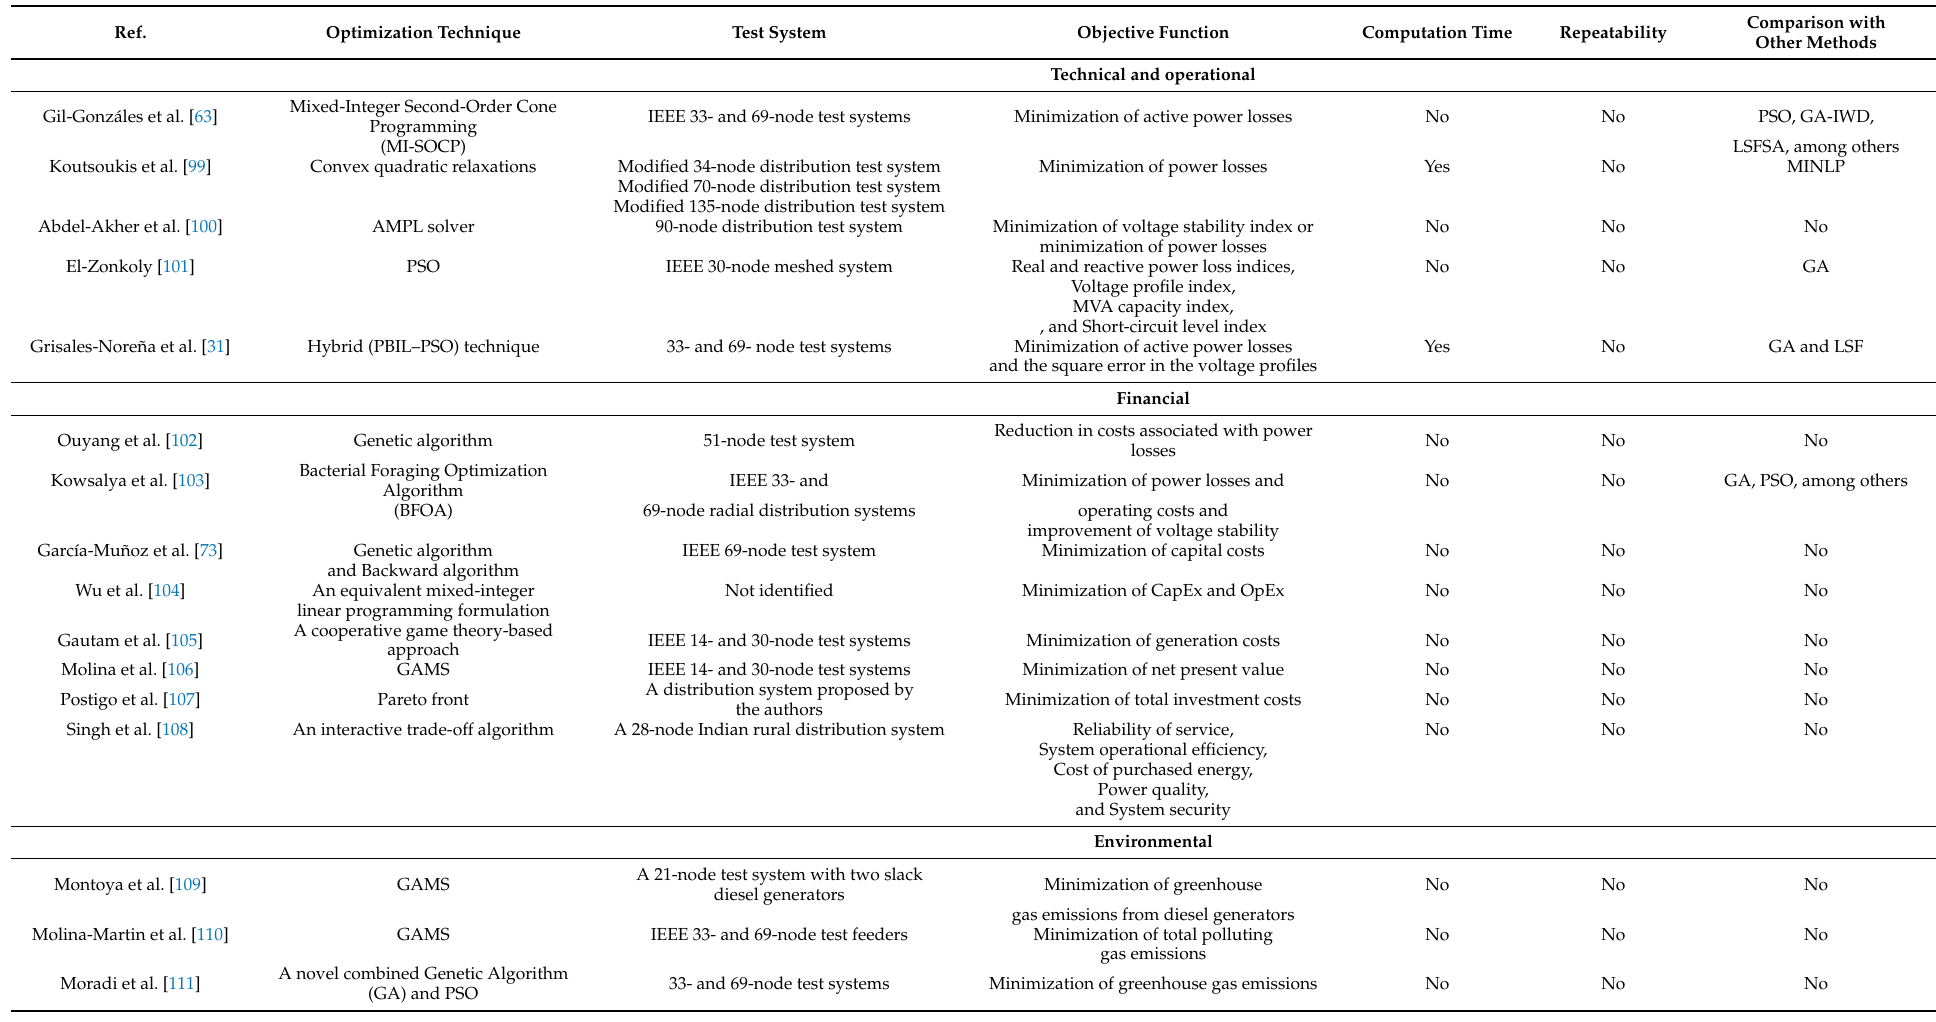
Table 1. Methodologies used in the literature for the optimal location and sizing of